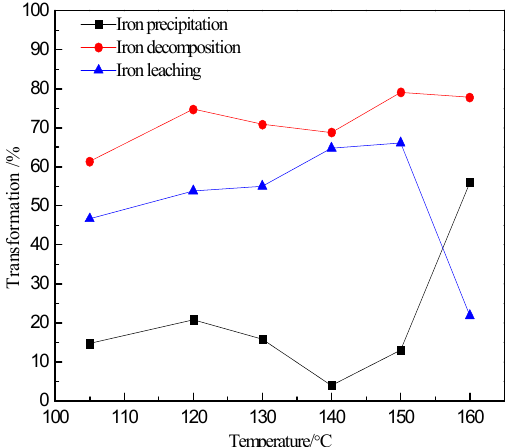
Figure 6. Relation between the iron extraction and extent of iron precipitation with temperature.